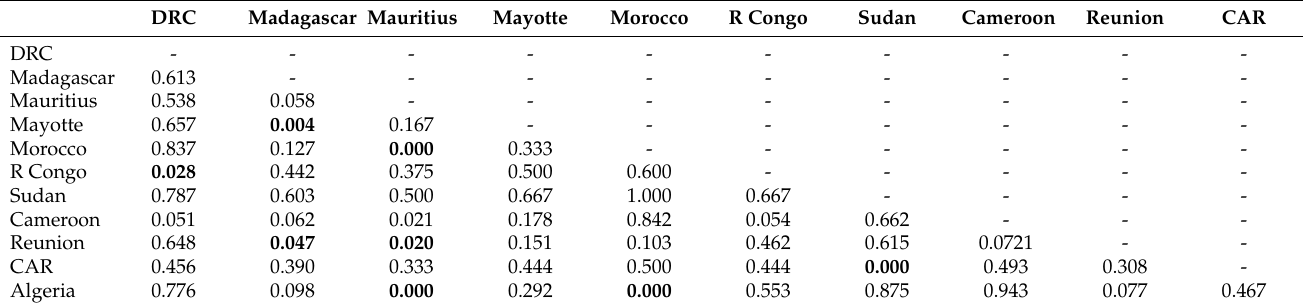
Table 2. Pairwise fixation index (Fst test values) between the African populations of Ae. albopictus calculated from the nucleotide datasets available in the GenBank.